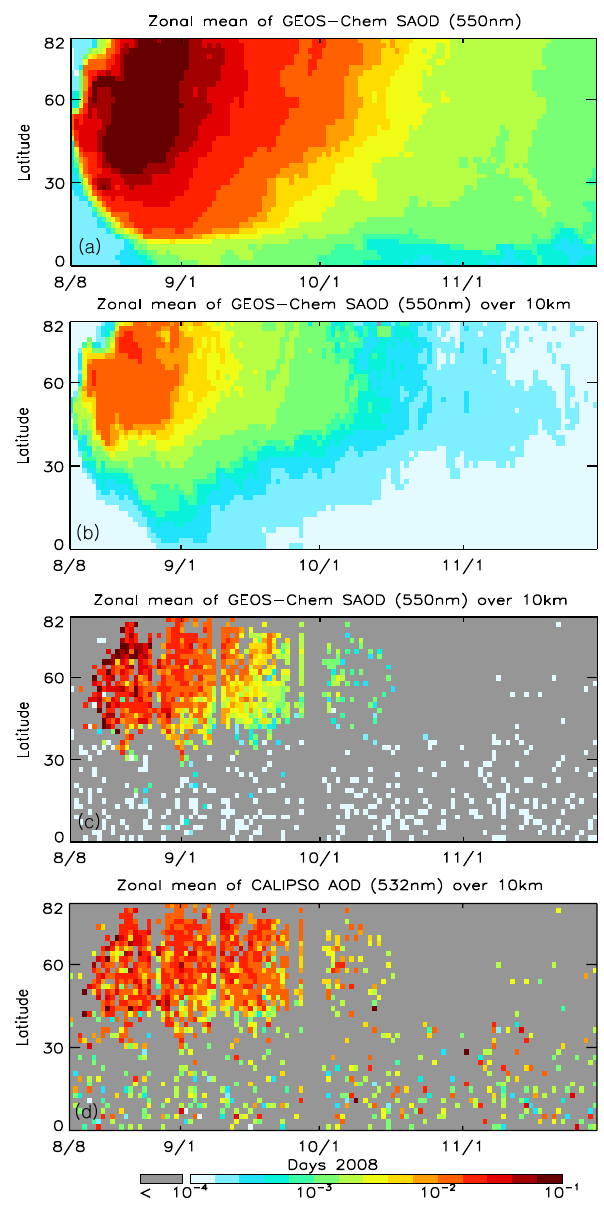
Fig. 7. (a) Temporal evolution of zonally averaged volcanic sulfate aerosol optical depth (SAOD) from GEOS-Chem simulations, (b) same as (a) but for SAOD above 10km from the surface, (c) the same as (b) but SAOD sampled along the CALIOP ground track, and (d) same as (c) but based upon the analysis of CALIOP level-2 aerosol layer product with the consideration of data quality